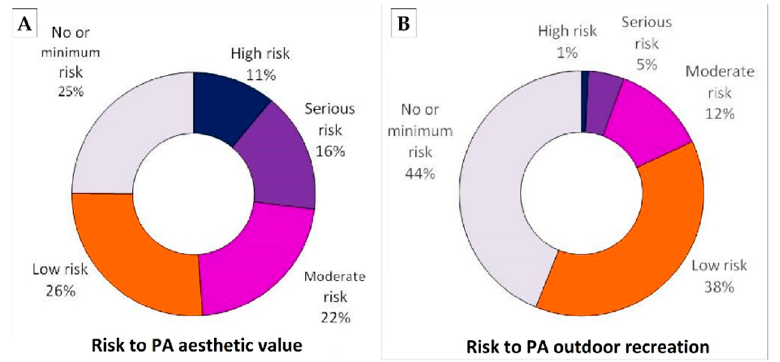
Figure 7. Sites showing the risk of degradation to CES values due to proposed wind turbine developments in Greece’s Natura 2000 network. Percentage of sites with potential risk to aesthetic values ( A ) and recreational values ( B ). Specific Natura site conflict risk (color codes) are as mapped in Figure 6 B and 6 C respectively.